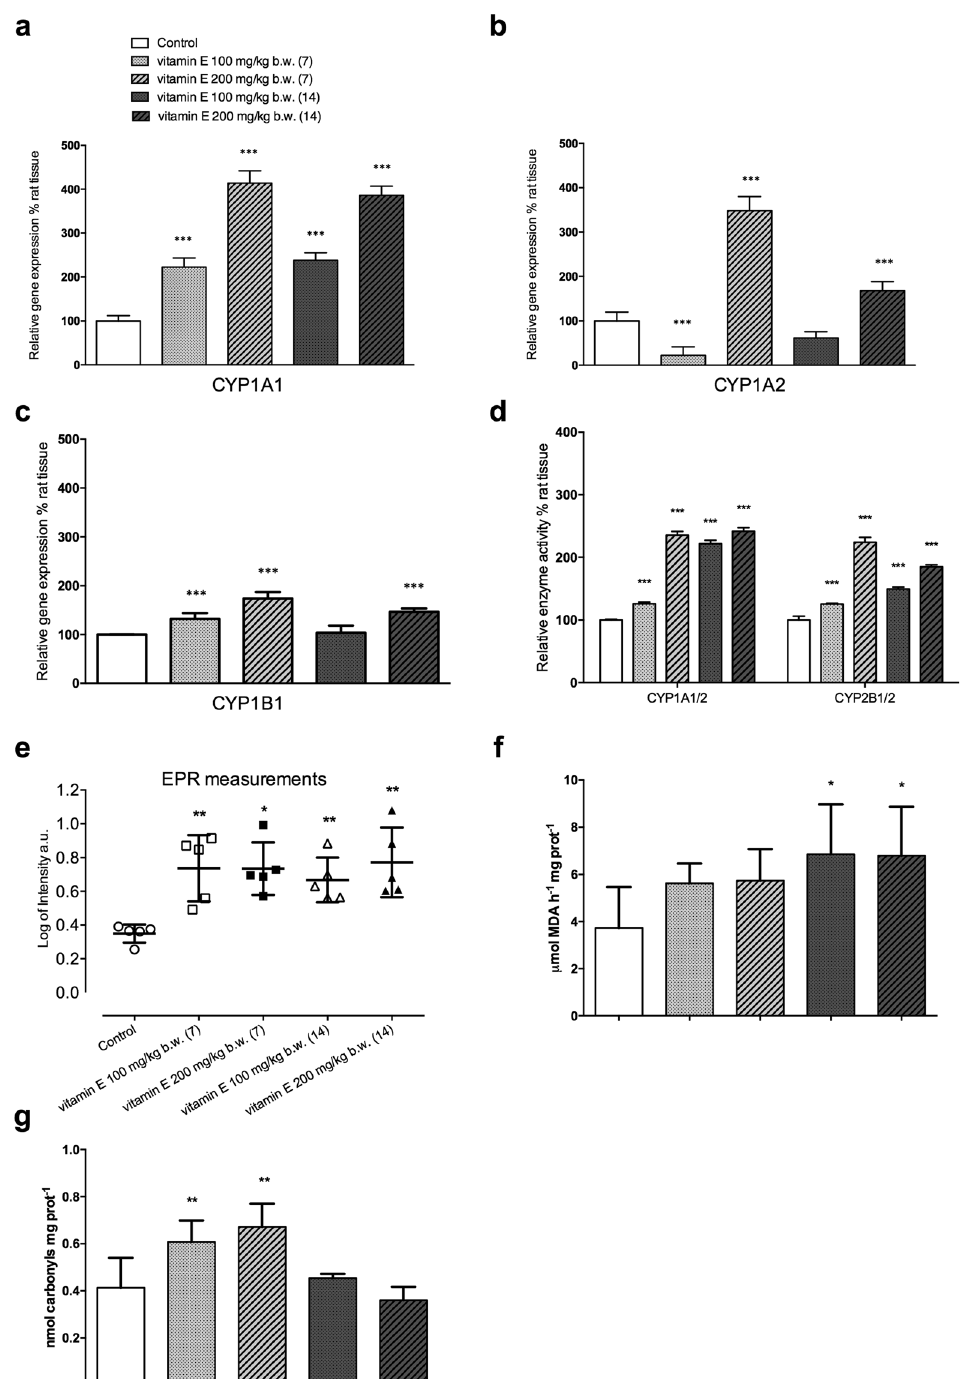
Figure 2. Vitamin E in rat prostate boosts CYP gene expression and linked enzymatic activities, and impairs the redox imbalance. ( a ) Data from RT-PCR analysis reported a marked increment of CYP1A1 throughout treatment ( P < 0.001; n = 5). ( b ) CYP1A2 presented a non-linear pathway of modulation with a significant inhibition at the lowest dose (7 days) that was not confirmed after 14 days. 200 mg/kg b.w. led to a net upregulation at both time windows. ( c ) CYP1B1 showed a trend similar to that described for CYP1A1 although changes were milder. 100 mg/kg b.w. treatment showed a 32% ( P < 0.001; n = 5) increment after 7 days that became non-significant at the fourteenth day. The highest dose resulted in 74 and 46% increments after 7 and 14 days, respectively ( P < 0.001; n = 5). ( d ) CYP1A1/2-ethoxyresorufin O -deethylase increased from 26% at the lowest dosage for 7 days to more than 100% after 14 days of treatment. The highest dose more than doubled at both time windows. CYP2B1/2-pentoxyresorufin O -dealkylase rose from 26 to 124% ( P < 0.01; n = 6), depending on the dose when vitamin E was administered for 7 days, whereas changes became less marked (about 85% and 50%) after 14 days( P < 0.0; n = 6). ( e ) EPR in prostate tissue biopsies from